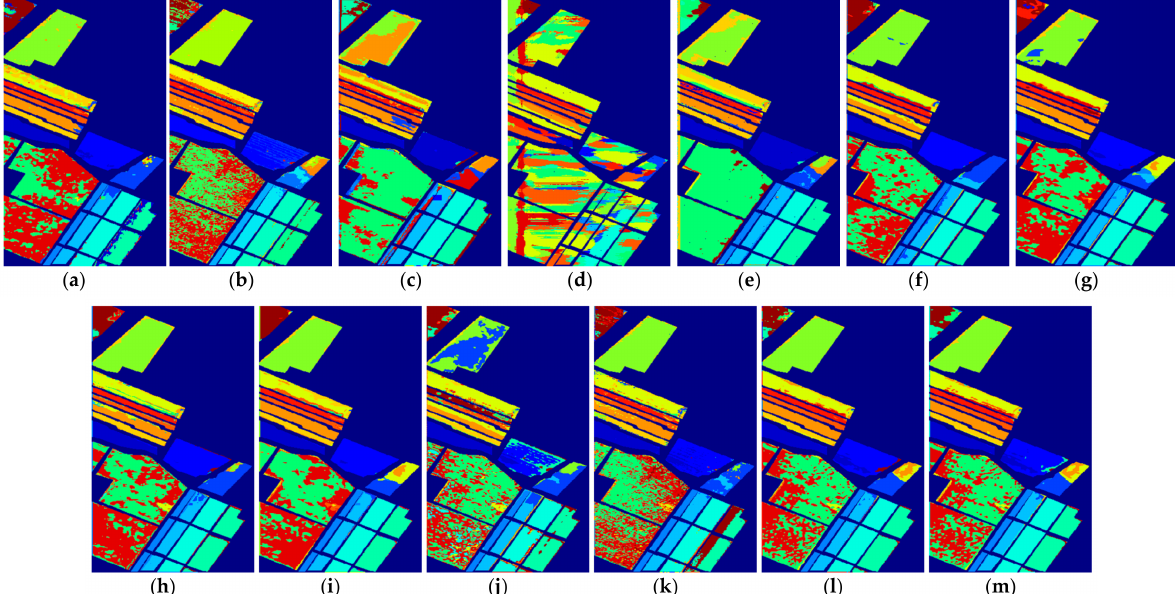
Figure 9. The classification maps of all methods with three samples on Salinas dataset. ( a ) SVM; ( b ) SS-LapSVM; ( c ) 3D-DENSEnet; ( d ) 3D-Gan; ( e ) SS-CNN; ( f ) 3D-CNN; ( g ) 3D-CNN k - means ( h ) 3D-CNN ours ; ( i ) 3D-CNN hardlabel ; ( j ) SSRN; ( k ) SSRN k - means ; ( l ) SSRN ours ; ( m ) SSRN hardlabel